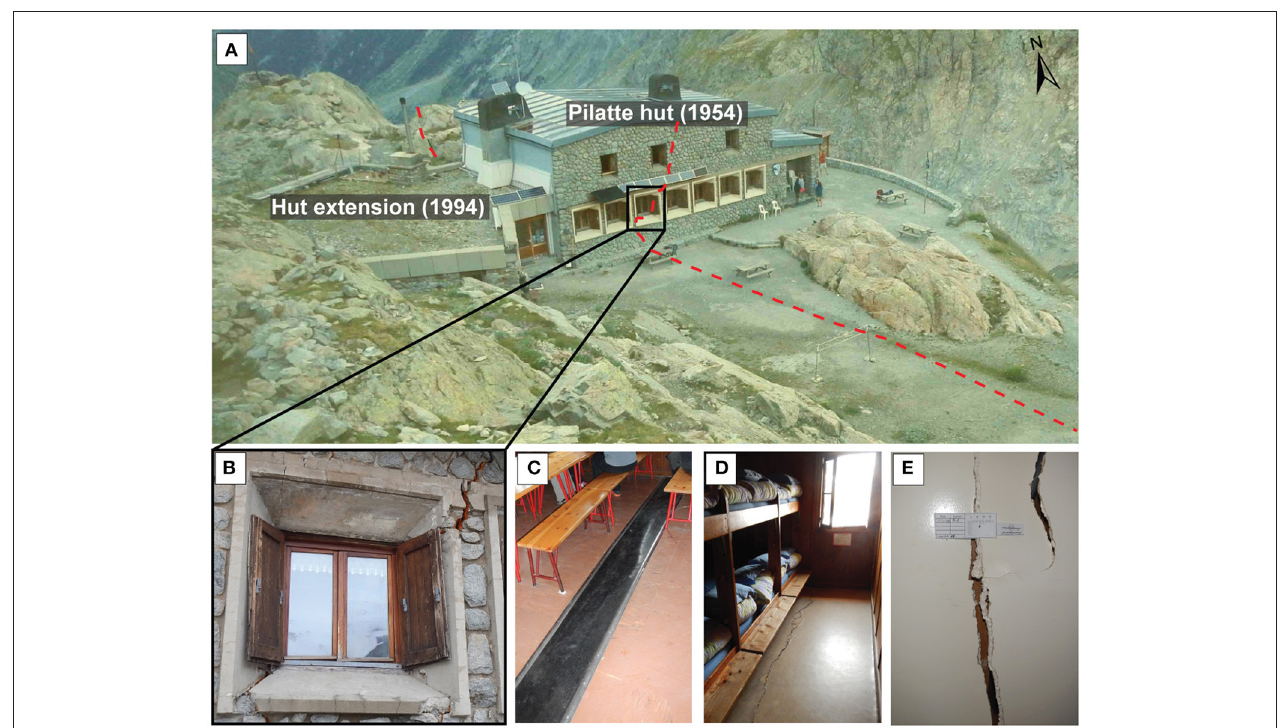
FIGURE 2 | Pilatte hut damage with main cracks shown. (A) The hut and the main fracture line (dashed red line). (B) South wall of the Pilatte hut and location of the fracture delimiting the back of the unstable rock mass in August 2016. (C–E) Photo taken in August 2016 of damage due to subsidence (E: Saugnac